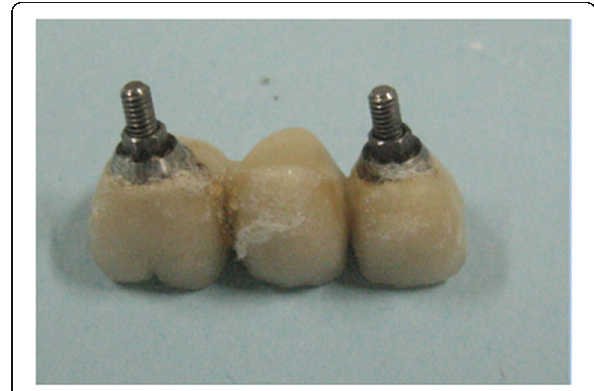
Fig. 1 Three-unit porcelain fused to a metal fixed partial denture